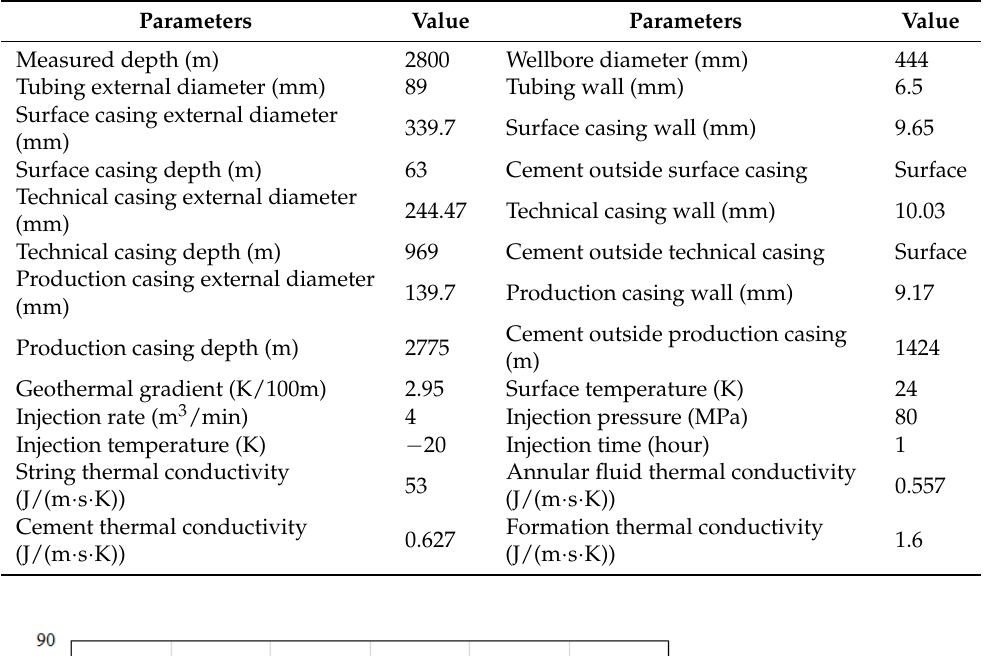
Table 2. Parameters of W-16.